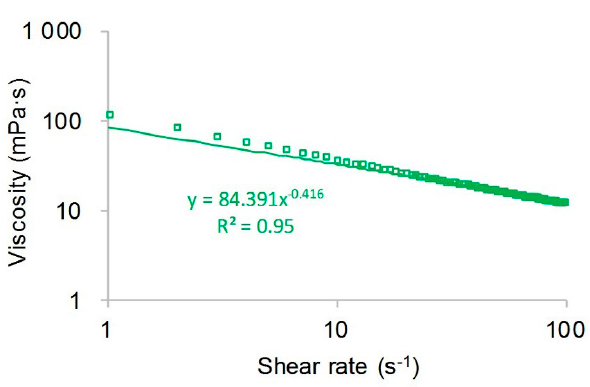
Figure 5. Shear thinning of polymer solution with a concentration of 1500 mg/L.